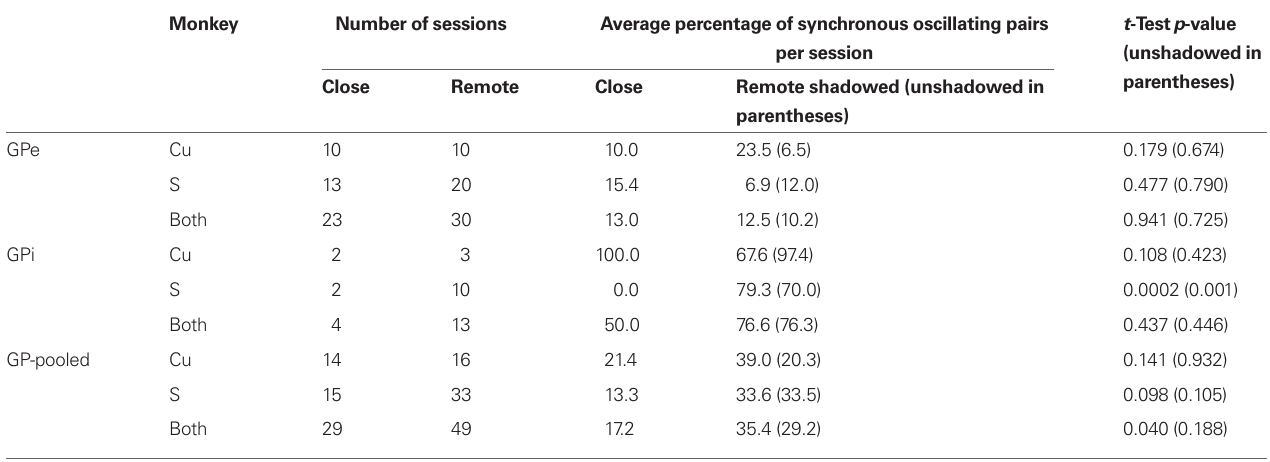
Table 3 | Average percentage of synchronous oscillating pairs per session: comparison between neighboring and remote cells. Monkey Number of